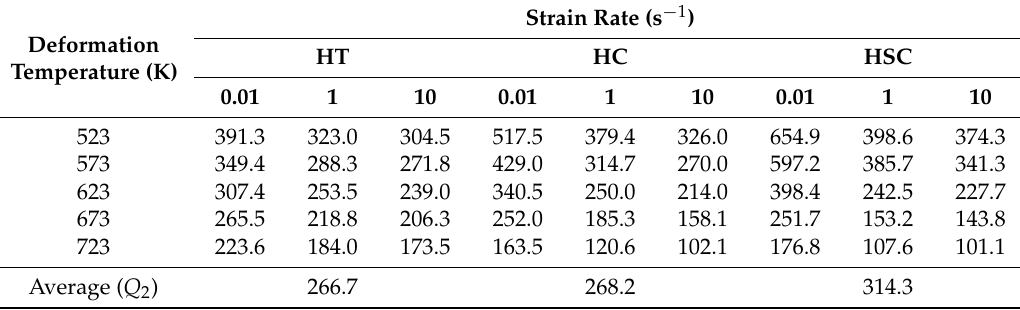
Table 3. Values of activation energy Q 2v for the 7050 aluminum alloy under three deformation modes.